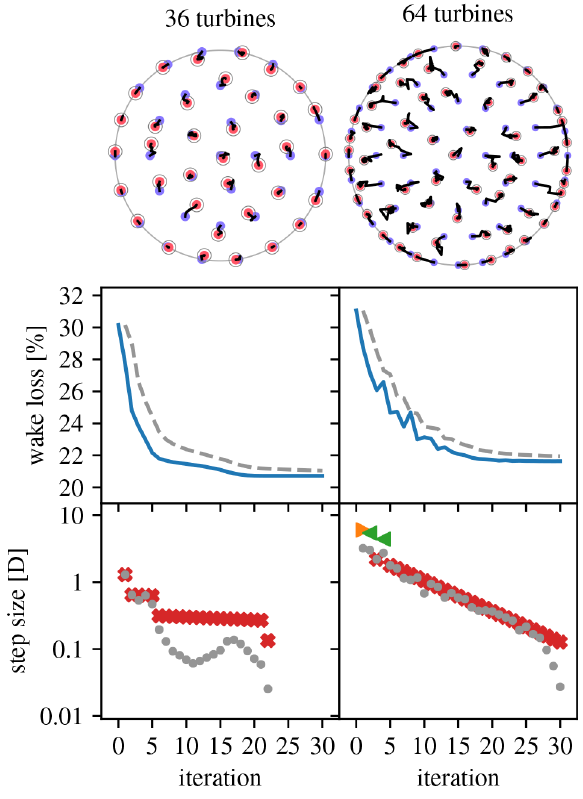
Figure 12. Overview of optimization runs for the IEA Wind Task 37 Case Study 1 36- and 64-turbine sites. (Legend in Table 1.)